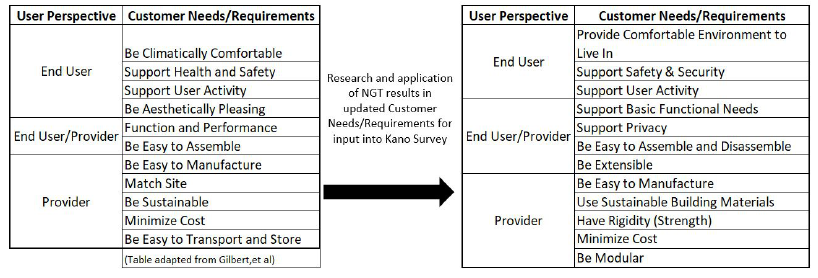
Figure 9. Customer needs/requirements for temporary refugee rural